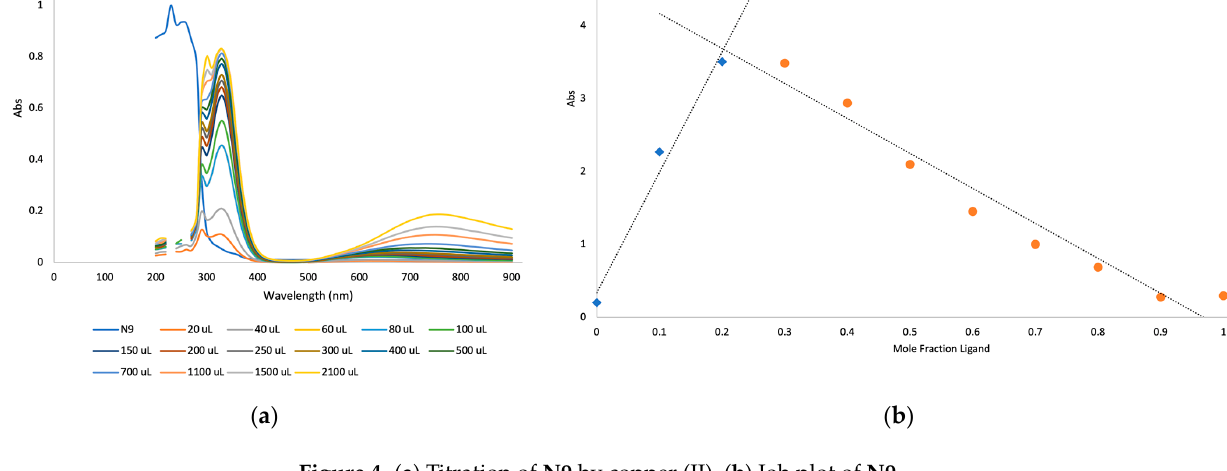
Figure 4. ( a ) Titration of N9 by copper (II). ( b ) Job plot of N9 .